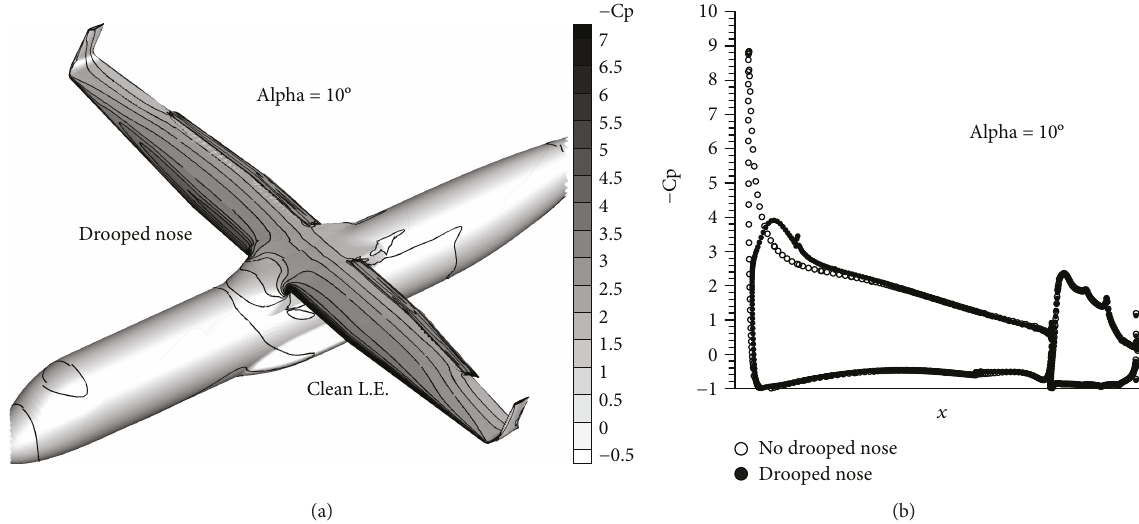
Figure 31: E ff ect of a droop nose on 3D Cp distribution (landing, alpha = 10 0 ° ).